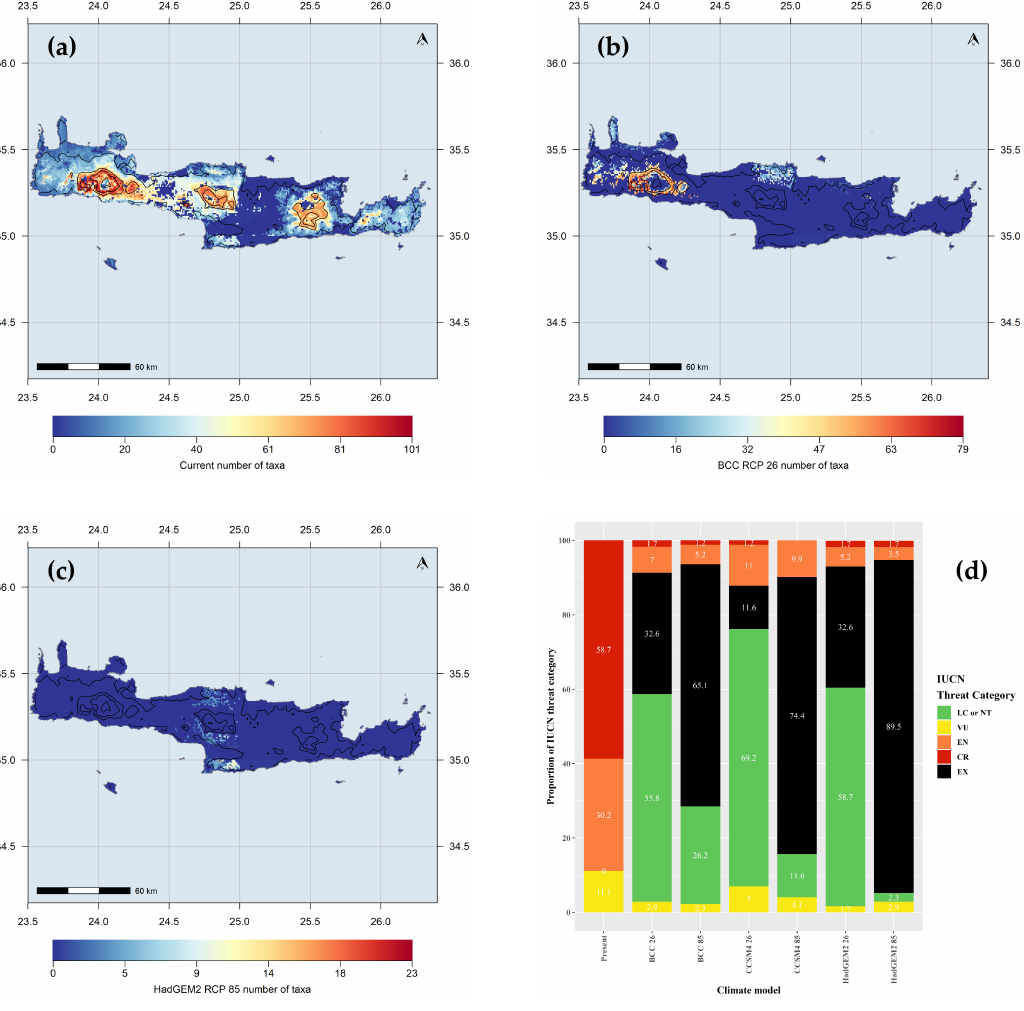
Figure 2. ( a ) Species richness map for the single island endemics (SIE) for the present time-period. ( b ) Species richness map for the SIE for the BCC 2.6 Global Circulation Model (GCM) and Representative Concentration Pathway (RCP) combination. ( c ) Species richness map for the SIE for the HadGEM2 8.5 GCM / RCP combination. ( d ). Proportion of the Cretan Single Island Endemics included in our analysis under the IUCN threat categories for the current conditions according to both Criterion A and B, as well as for every GCM and RCP considered in the present study. Note that we present the best- and worst-case scenarios in terms of future species richness. The black lines denote the altitudinal contours starting from 500 m